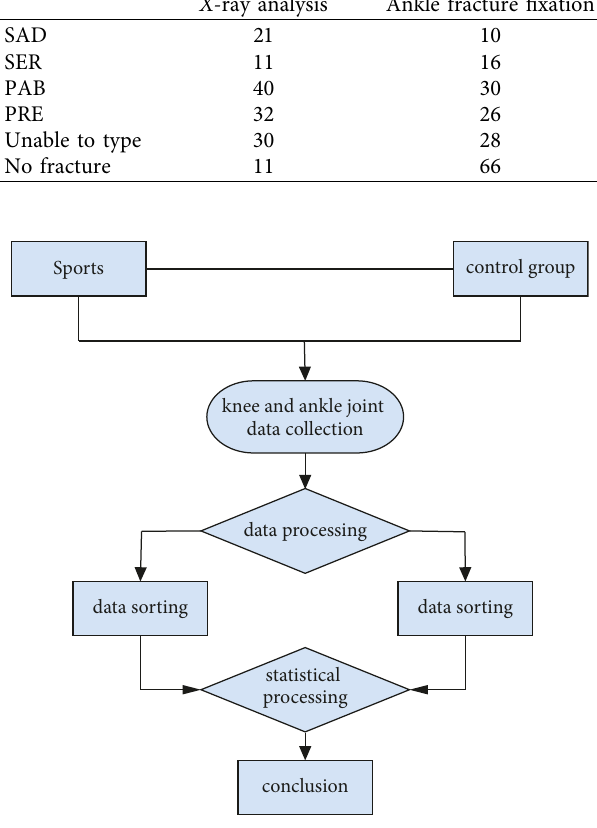
Figure 3: Flowchart of sports